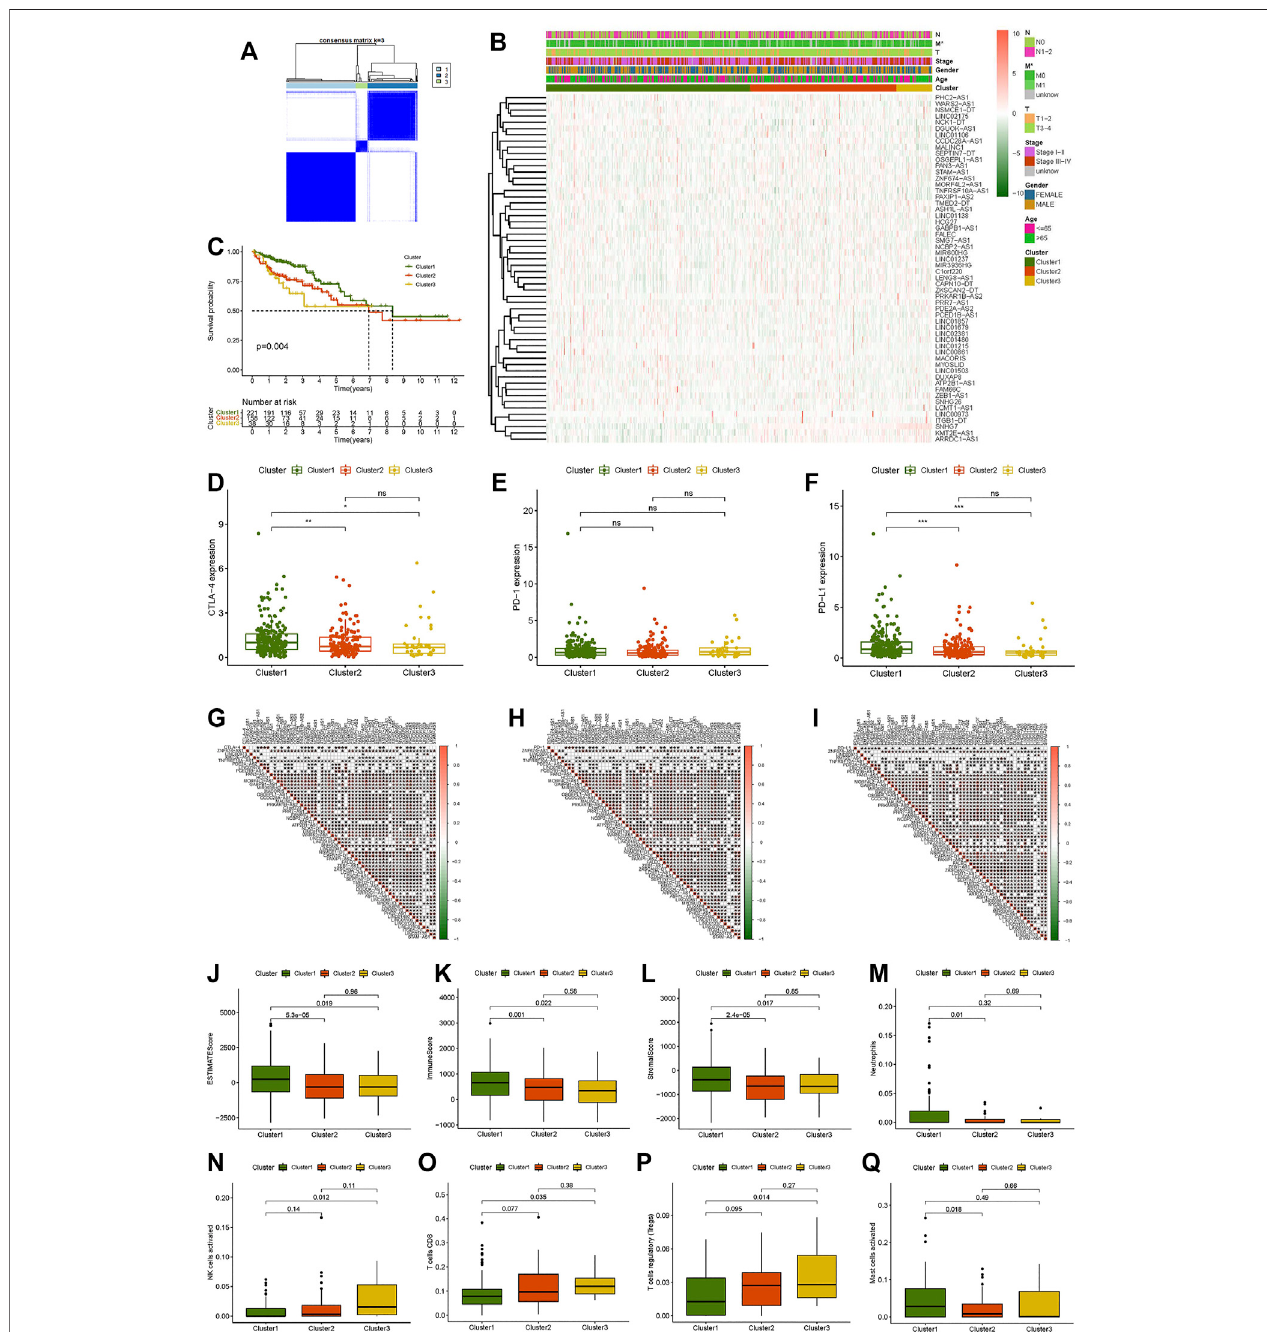
FIGURE 2 | Consensus clustering analysis of necroptosis-related lncRNAs and immune correlation analysis. (A) Consensus clustering matrix for k = 3. (B) Heat map and clinicopathologic features of Clusters 1, 2, and 3. (C) Kaplan – Meier curves of overall survival (OS) of Clusters 1, 2, and 3. (D – F) CTLA-4, PD-1, and PD-L1 expression levels of Clusters 1, 2, and 3. (G – I) Correlation between CTLA-4, PD-1, and PD-L1 expression levels and differential expression of necroptosis-related lncRNAs. (J) ESTMATE score. (K) Immune score. (L) Stromal score. (M) Neutrophils. (N) Activated NK cells. (O) CD8 T cells. (P) Regulatory T cells (Tregs). (Q) Activated mast cells. * p < 0.05, ** p < 0.01, *** p <